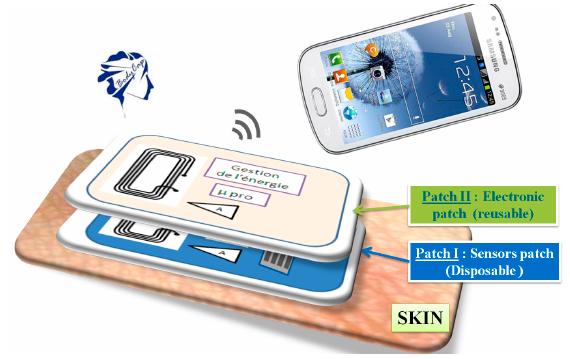
Figure 1. Principle of second skin concept.